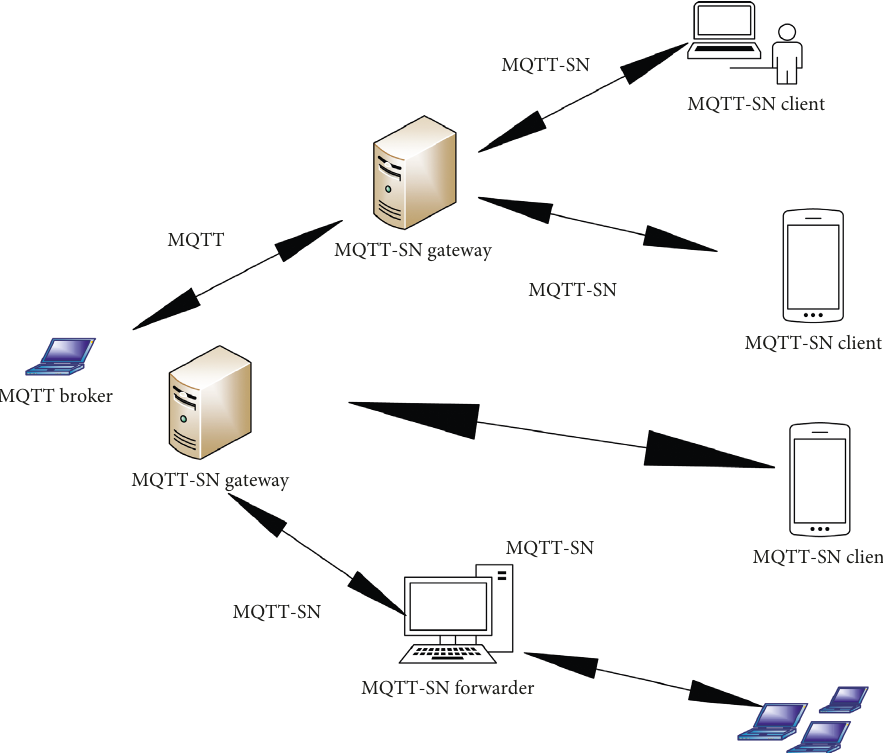
Figure 5: MQTT-SN